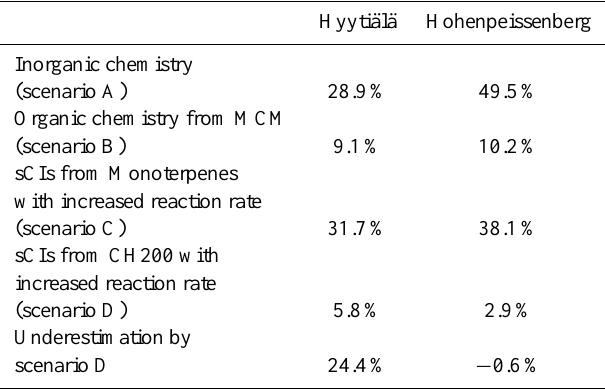
Table 3. Contribution of the different chemical paths to form sulfu- ric acid in the